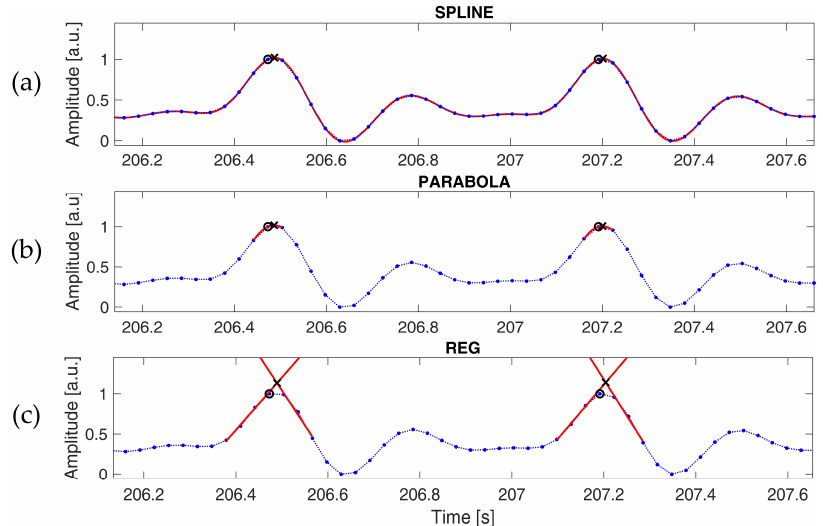
Figure 2. Application of the described interpolation strategies ( a : SPLINE; b : PARABOLA; c : REG) to the peaks identified through the ENVELOPE method. The first derivative of a PPG signal sampled at 32 Hz is shown (blue dots). The following is in red: spline-interpolated first derivative ( a ), parabola approximation ( b ), regression curves estimated on the ascending and descending segments ( c ). The plots show the peaks detected on the subsampled signal (O) and those identified through interpolation (X).